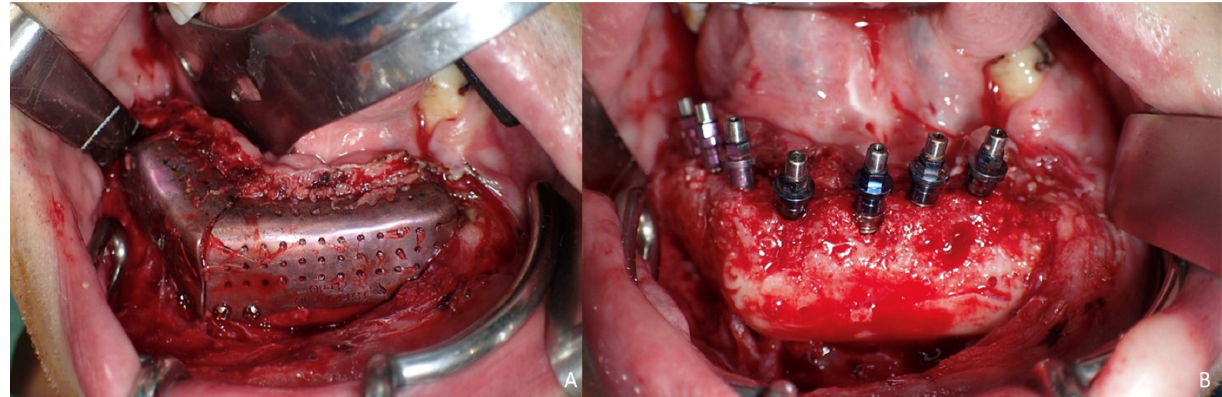
Figure 7. Postoperative CT scan. ( A ) Axial CT Scan demonstrating the stability of the transverse dimension of the fibula with respect to the remnant mandible. ( B ) The three-dimensional preservation of the iliac crest graft with CAD/CAM mesh makes it possible to double the height of the fibula.